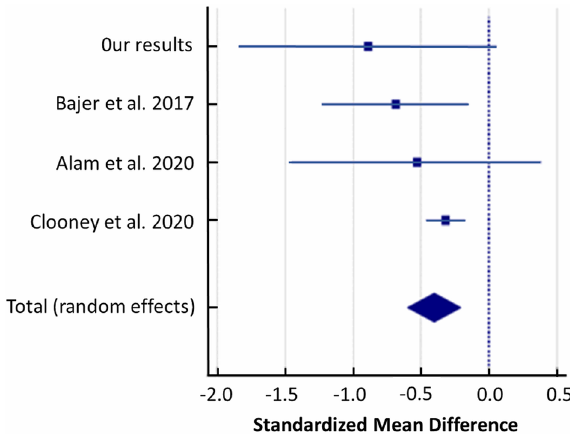
Figure 8. Forest plot of random-effects meta-analysis including studies evaluating the abundance of Christensenellaceae in UC patients versus healthy controls.